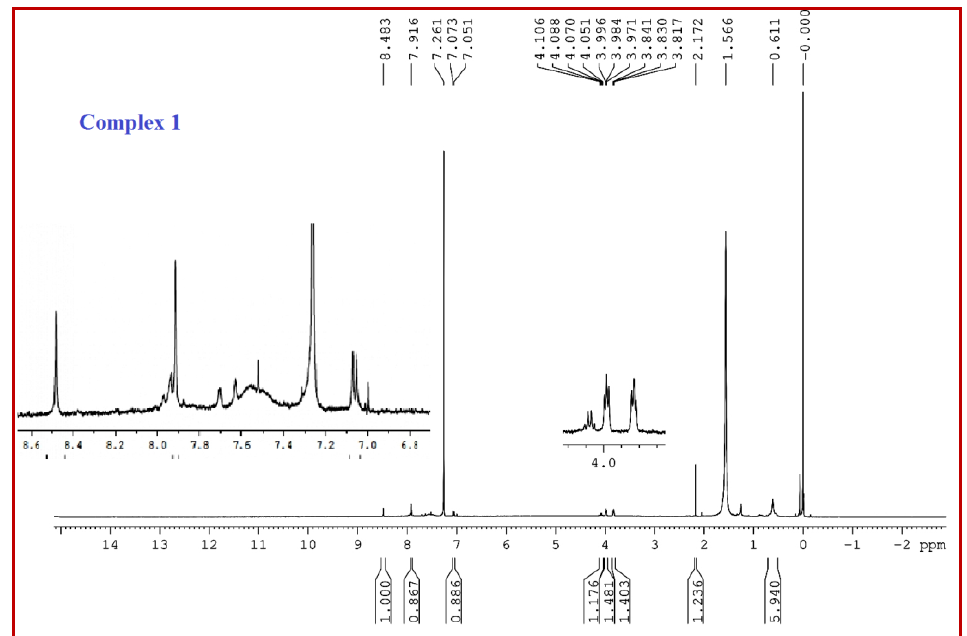
Figure 2. 1 H NMR spectrum of the complex 1 .